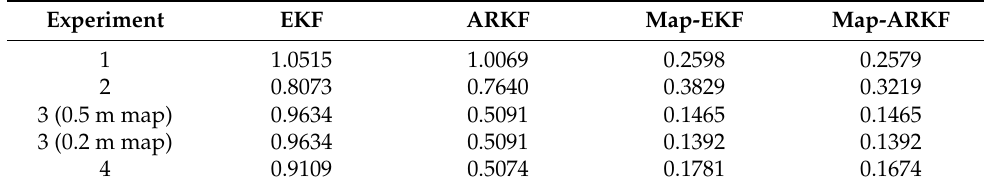
Table 4. RMSE for the four algorithms (unit: m).